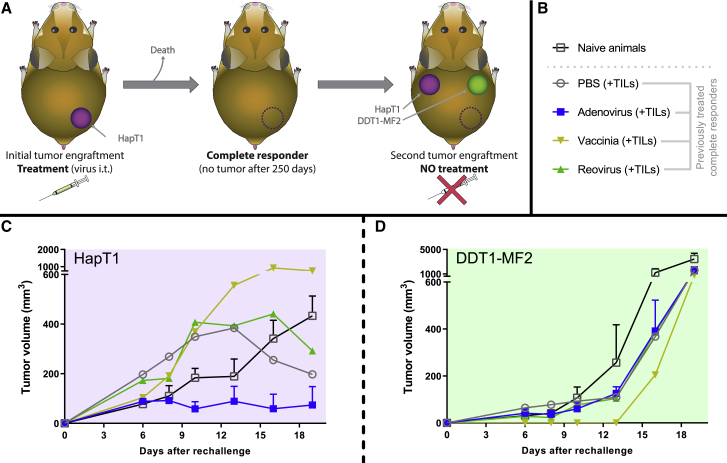
Study of Antitumor Memory in Complete Responders(A) Experimental design: animals treated with ACT and different oncolytic viruses (or PBS) experiencing complete responses were rechallenged with HapT1 and challenged with DDT1-MF2 to study antitumor-specific memory (no additional treatments given). In addition, naive animals were simultaneously engrafted with HapT1 and DDT1-MF2 tumors. (B) Groups included in the experiment: naive animals group (n = 3), PBS + TILs group (n = 1), adenovirus + TILs group (n = 5), vaccinia + TILs (n = 1), and reovirus + TILs (n = 1). The number of animals depended on how many had been cured in the first part of the experiment. (C) Mean (and SEM) tumor volumes for the HapT1 tumors. (D) Mean (and SEM) tumor volumes for the DDT1-MF2 tumors.